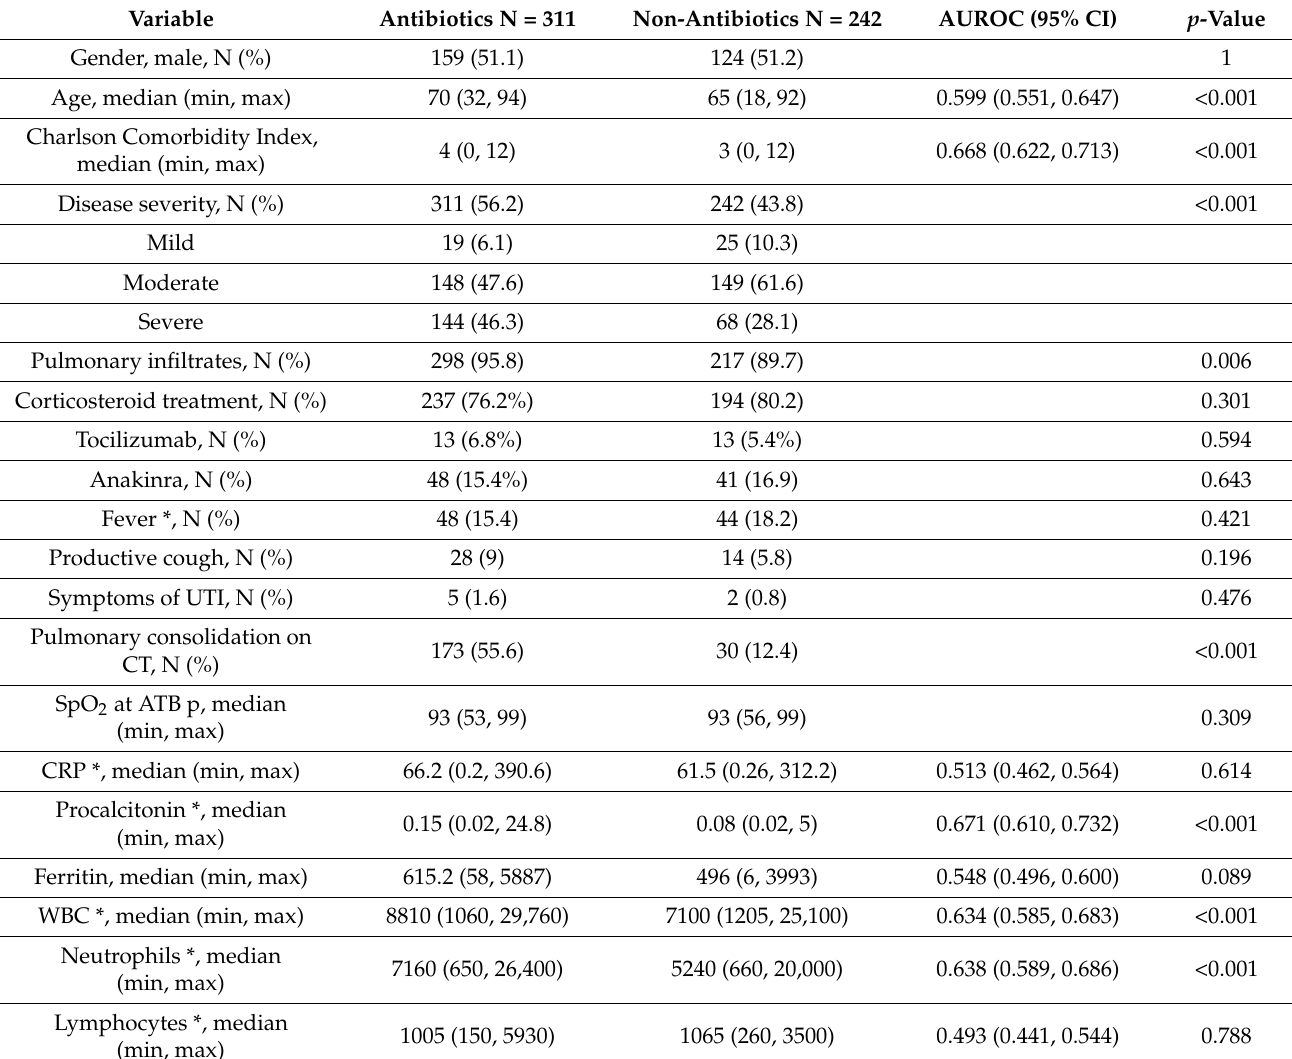
Table 2. The distribution of the variables according to antibiotic prescription.